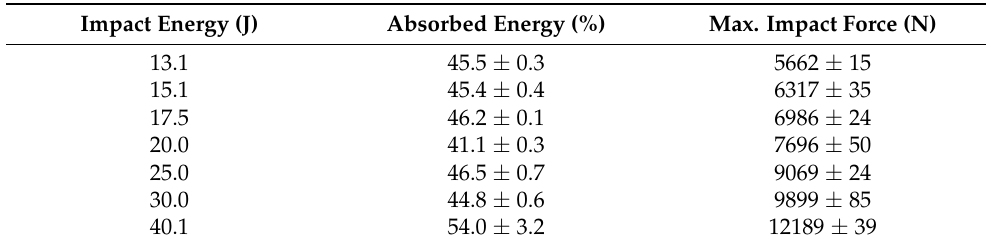
Figure 5. Impactor contact force for each impact energy tested on the reference CFRP. Table 1. Absorbed energy and maximum impactor contact force for each level of impact energy performed on the reference CFRP.